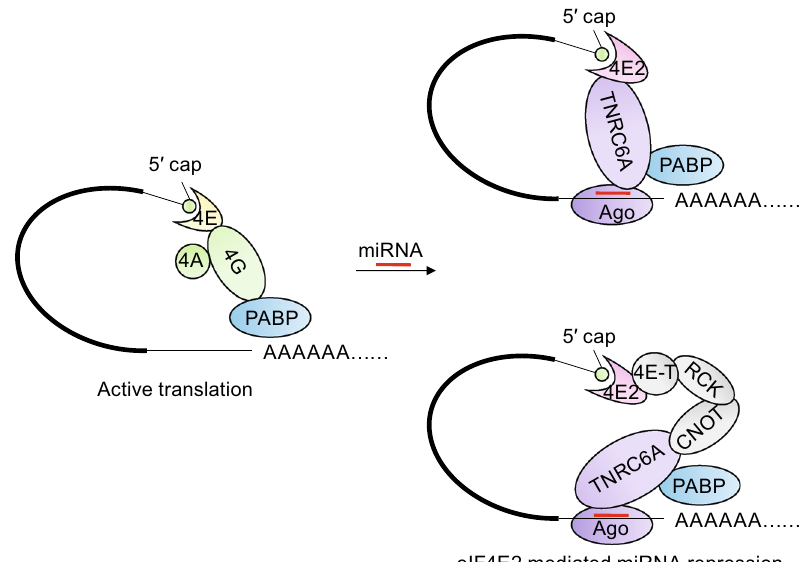
Figure 7. Working models for eIF4E2-mediated miRNA repression of target mRNA translation. In the absence of miRNA, target mRNA is translated actively as a 5 ′ cap-eIF4E-eIF4G-PABP-3 ′ poly(A) closed loop (left). In the presence of miRNA, RISC is loaded on the target mRNA, and eIF4E2 is recruited to the 5 ′ cap through direct interaction with TNRC6A (upper-right) or through the CNOT- RCK-4E-T axis (bottom-right) to compete with eIF4E, resulting in translational